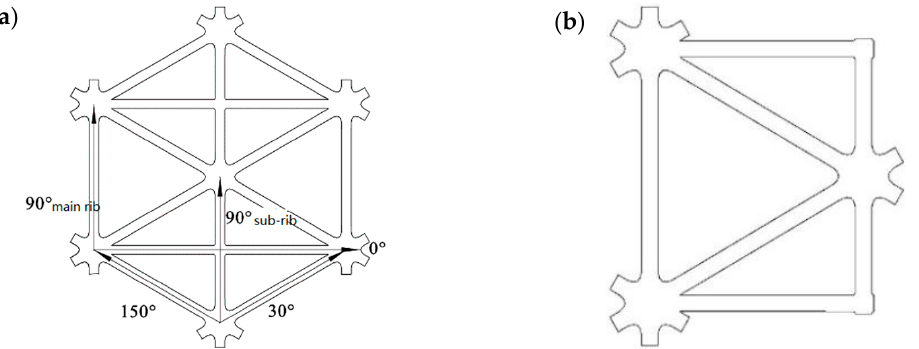
Figure 2. Structure of performance optimized multi-axial geogrid. ( a ) Rib naming method ( b ) Basic structural unit.